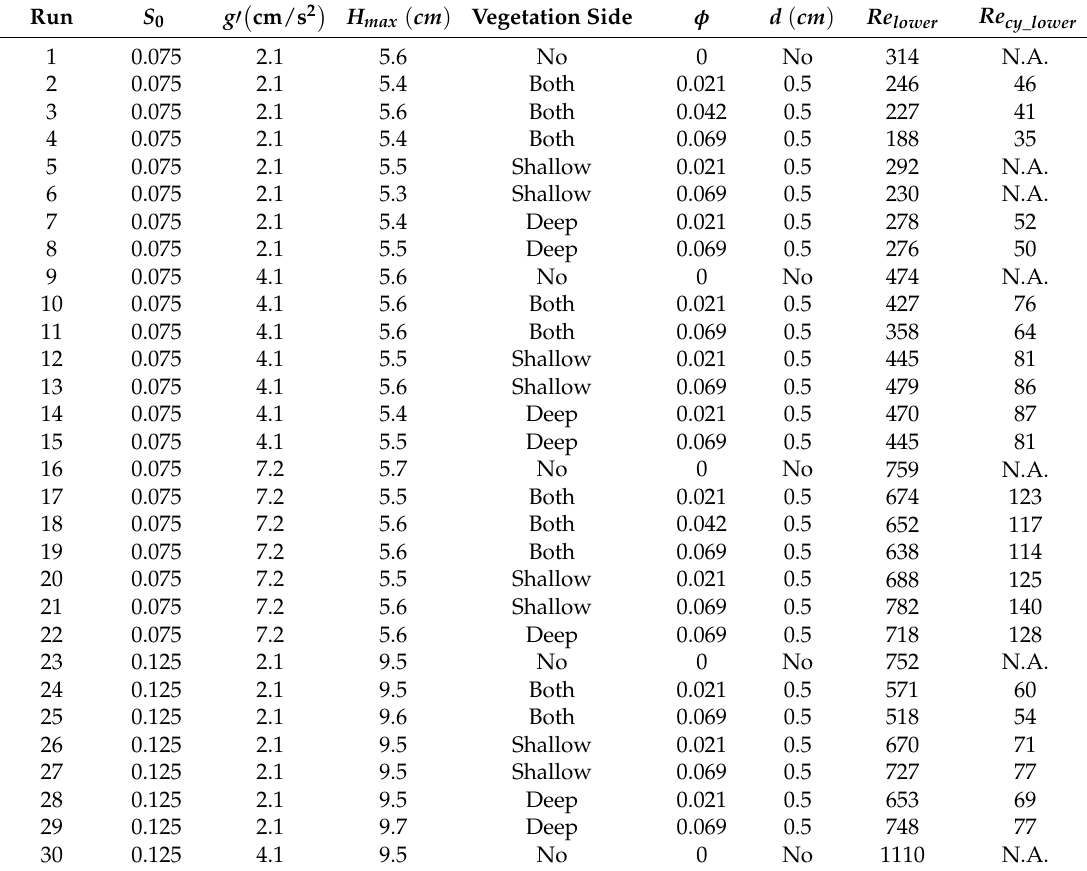
Table 1. Summary of the experimental conditions and relevant